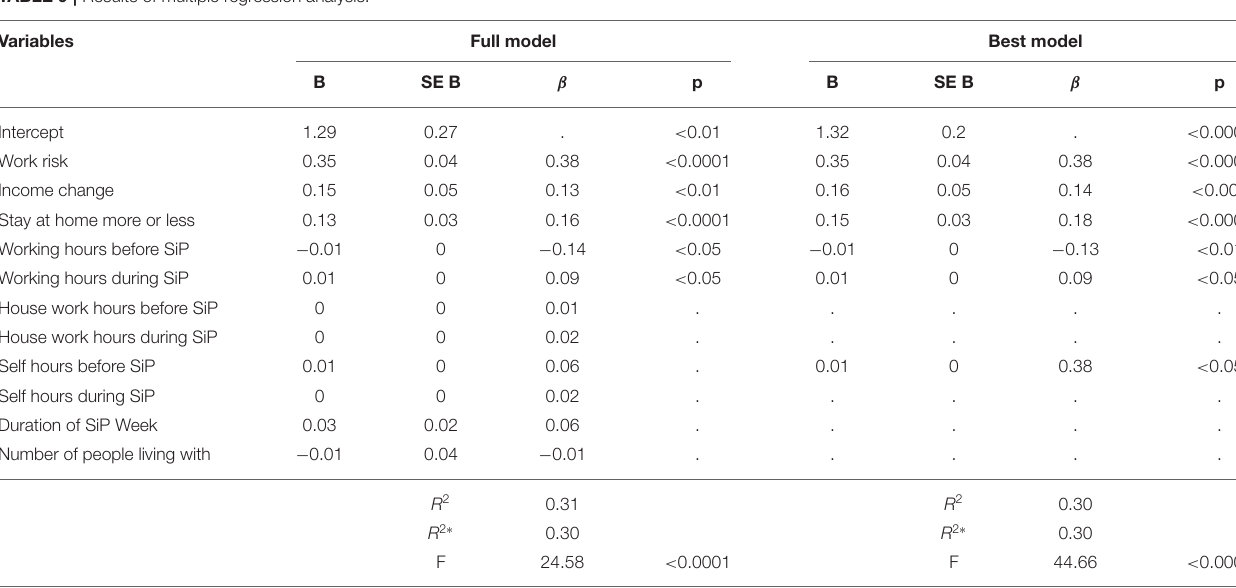
TABLE 9 | Results of multiple regression analysis.